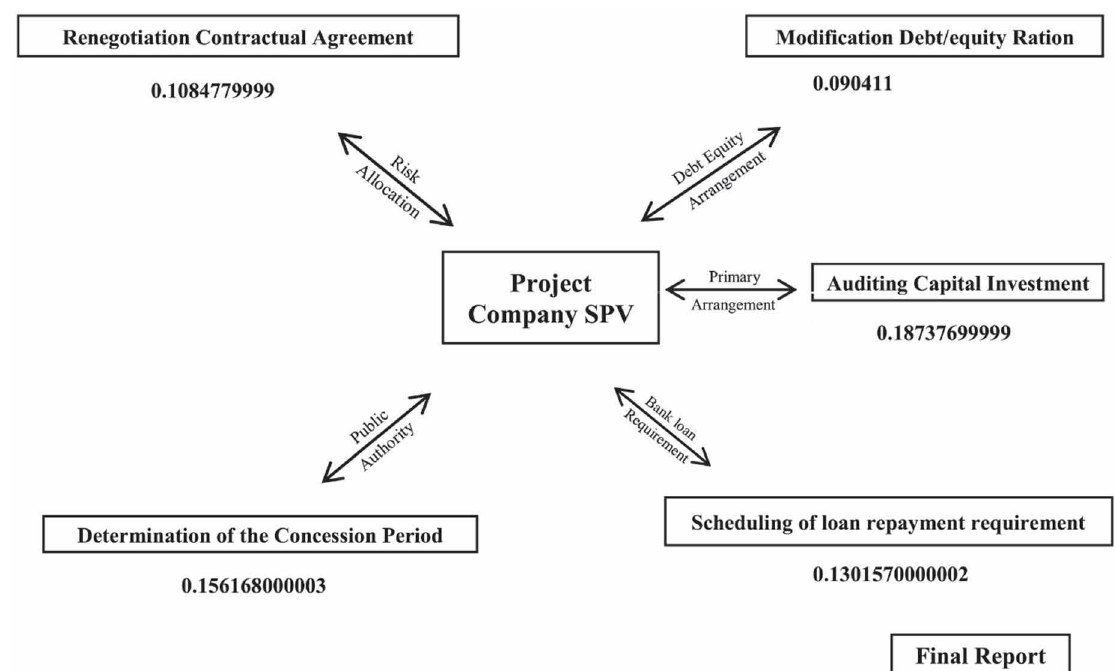
Figure 8. The proposed adoption of PPPs structures as RAA3P system’s